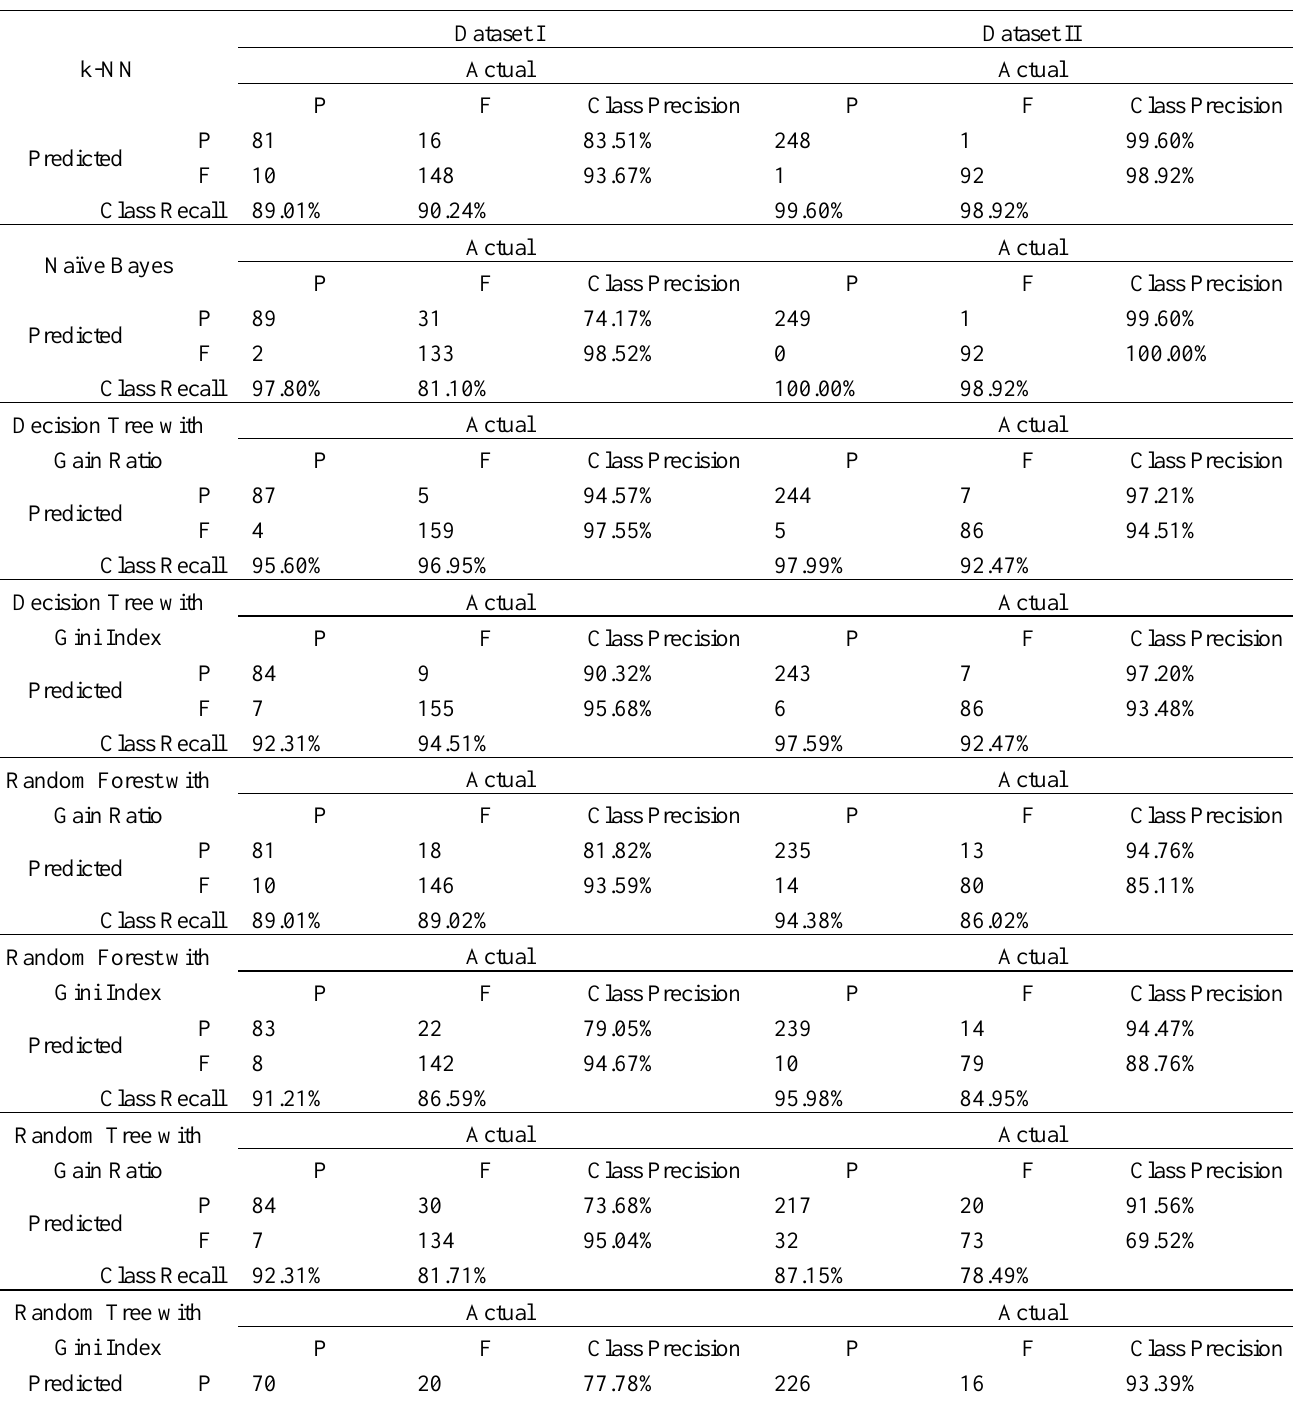
Confusion Matrices of Technical